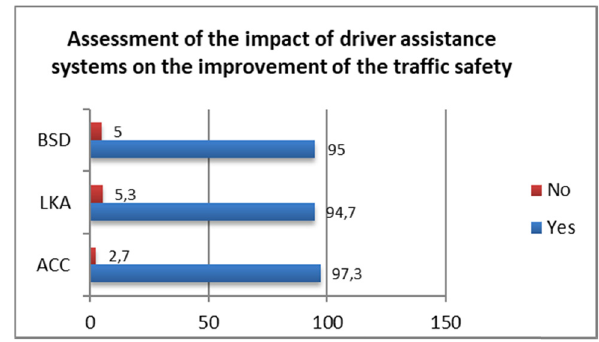
Figure 9: Assessment of the impact of driver - assistance systems on the improvement of the tra ffi c safety ( % ) . Source: author ’ s own